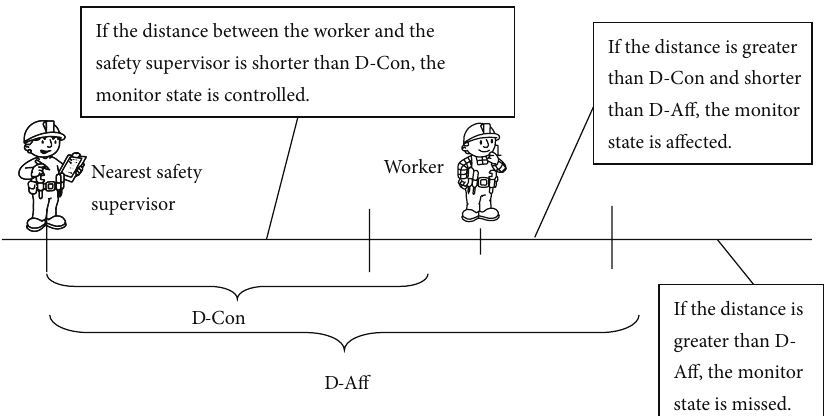
Figure 4: Definition of monitor states with safety supervisor.